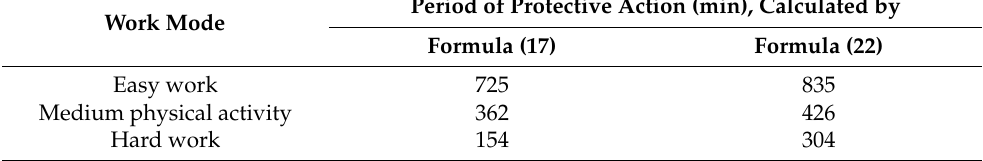
Table 5. Comparison of the protective action period of “Standart” respirators, calculated at a dust concentration of 50 mg/m 3